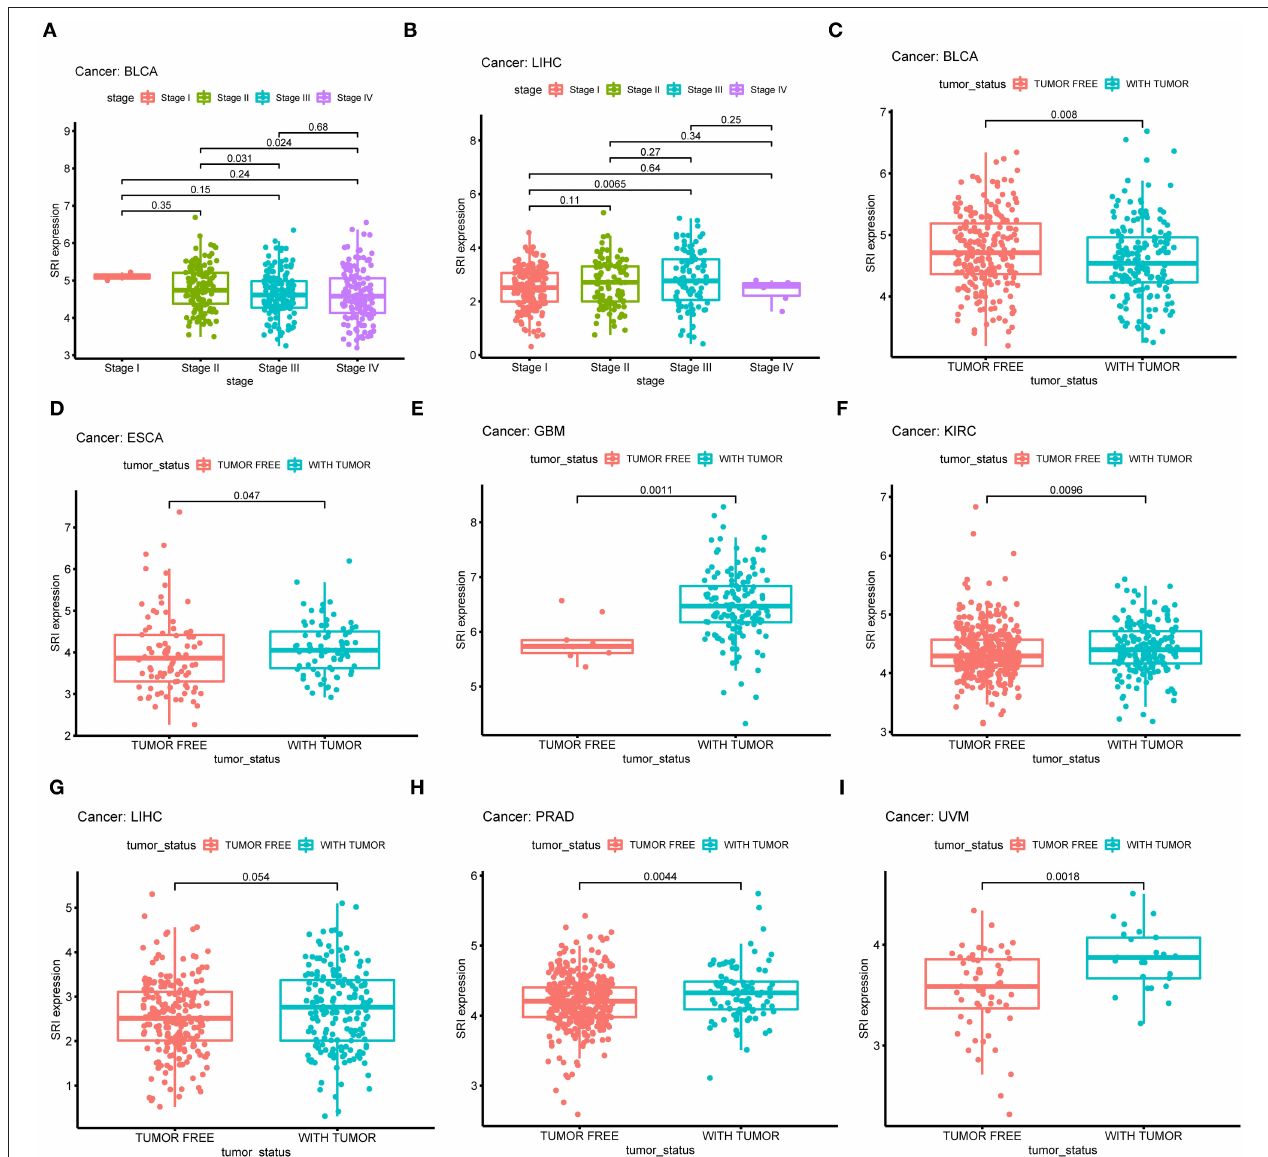
FIGURE 5 | Correlation between SRI expression and stage in (A) bladder urothelial carcinoma (BLCA), (B) liver hepatocellular carcinoma (LIHC). Correlation between SRI expression and tumor status in (C) bladder urothelial carcinoma (BLCA), (D) esophageal carcinoma (ESCA), (E) glioblastoma multiforme (GBM), (F) kidney renal clear cell carcinoma (KIRC), (G) liver hepatocellular carcinoma (LIHC), (H) prostate adenocarcinoma (PRAD), and (I) uveal melanoma